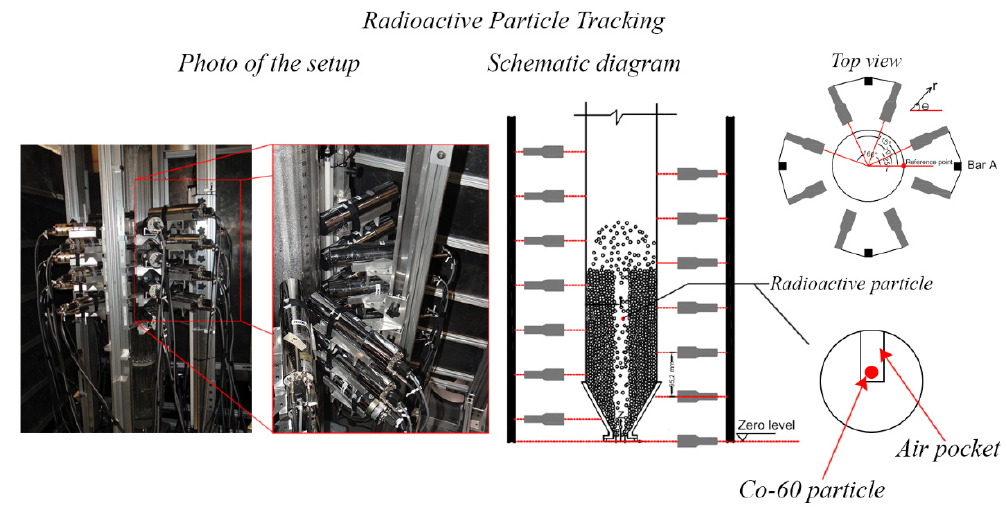
Figure 6. Details of the Radioactive Particle Tracking technique.